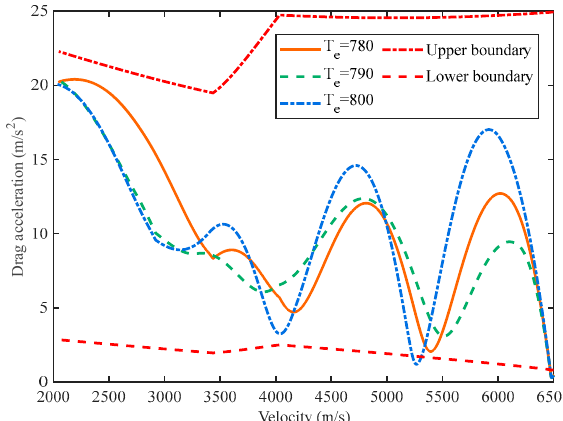
Figure 5. Resistance acceleration reentry corridor.